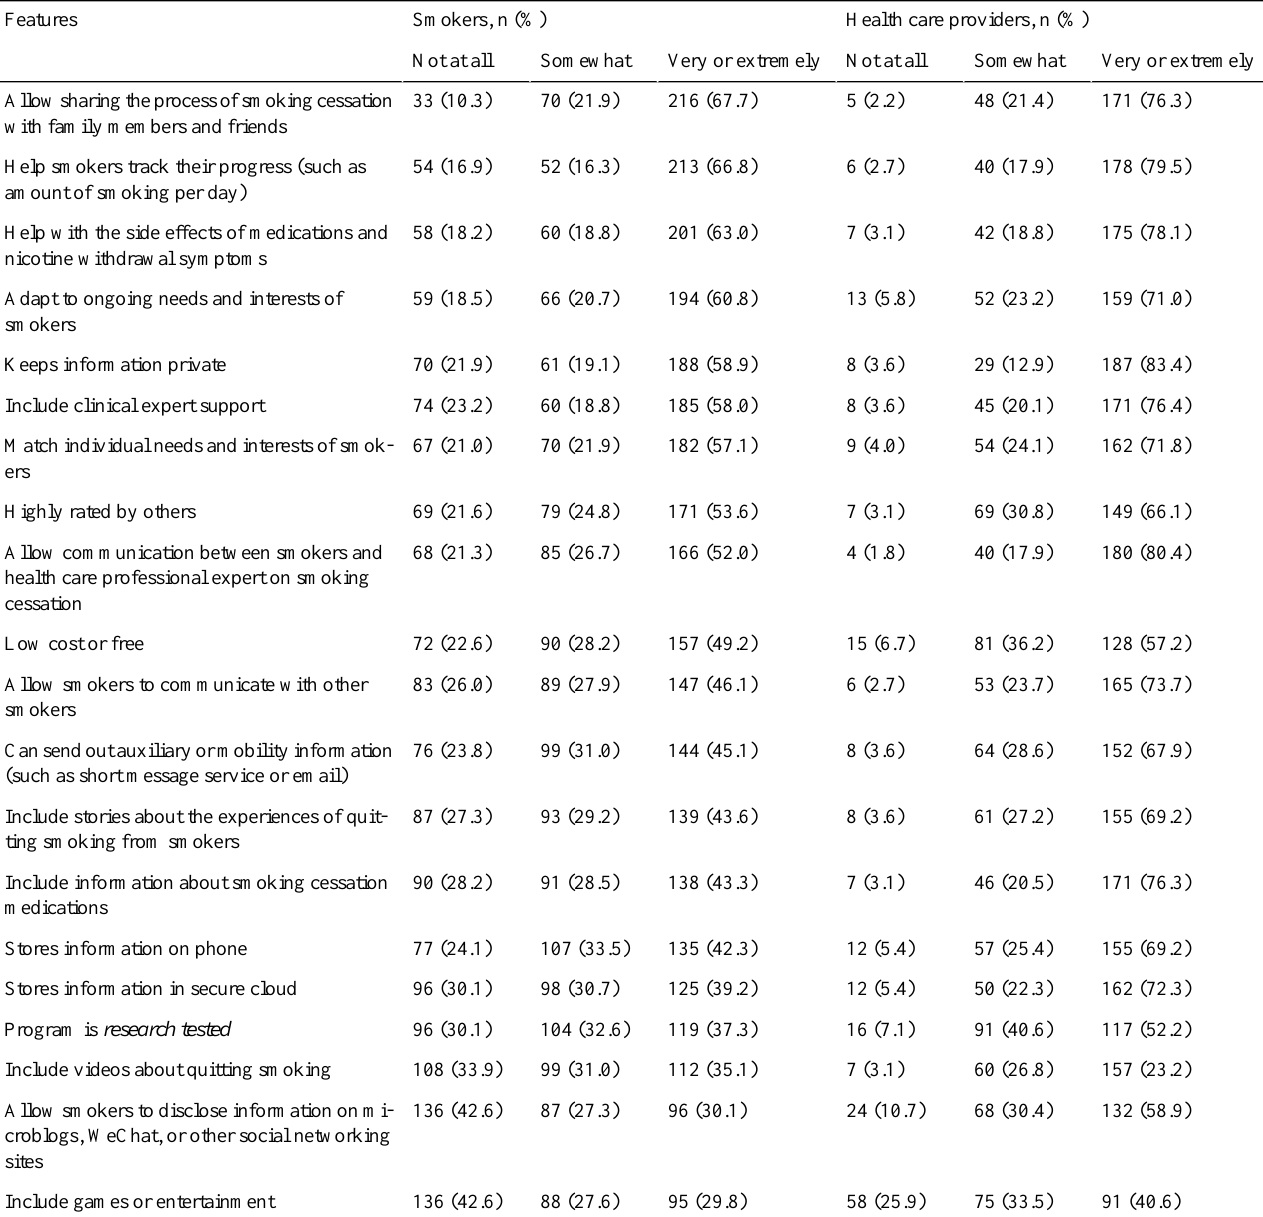
Table 4. Smokers and health care providers’ratings about smoking cessation apps